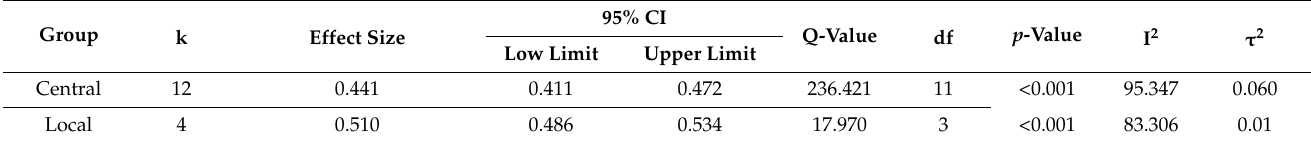
Table 6. Subgroup analysis results.